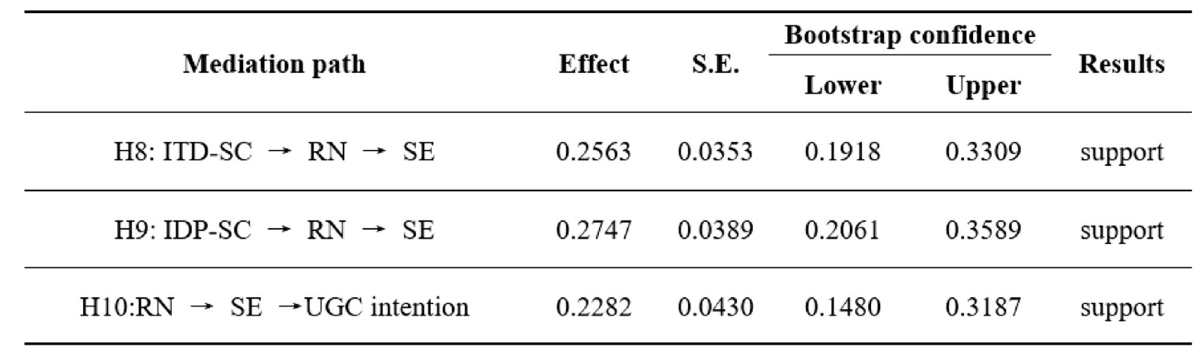
Table 5 Estimated values of Bootstrap mediation analysis